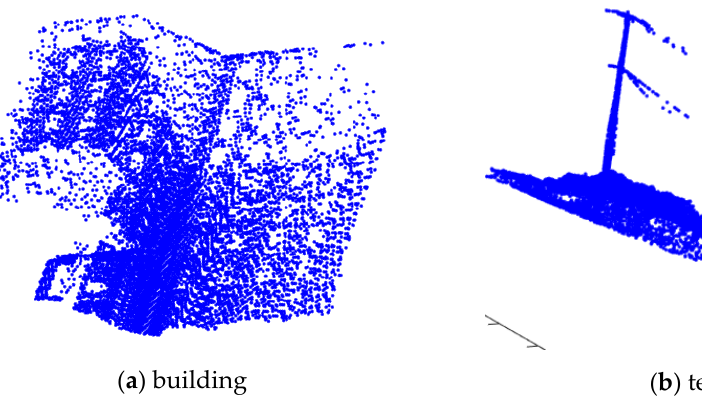
Figure 14. Tested point cloud.